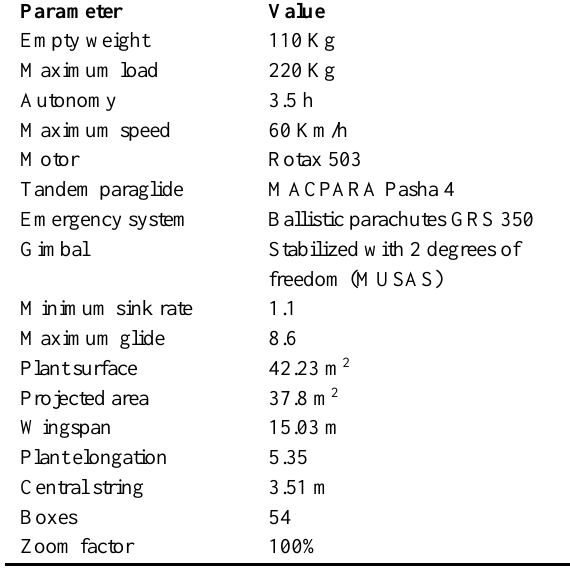
Table 1.Technical specifications of the manned aerial platform, aerial trike.